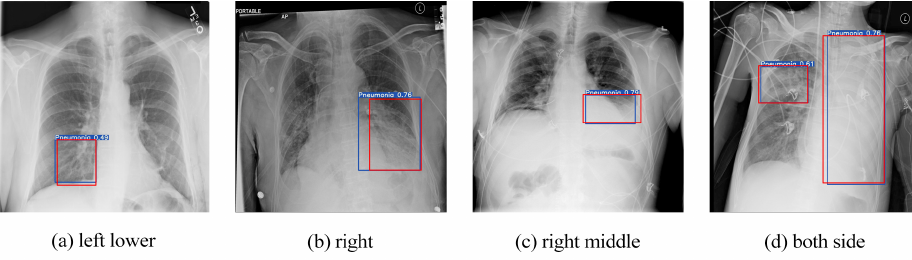
Figure 4. Four samples of pneumonia-related lesion detection. The red bounding boxes display the ground truth while the blue ones show the prediction